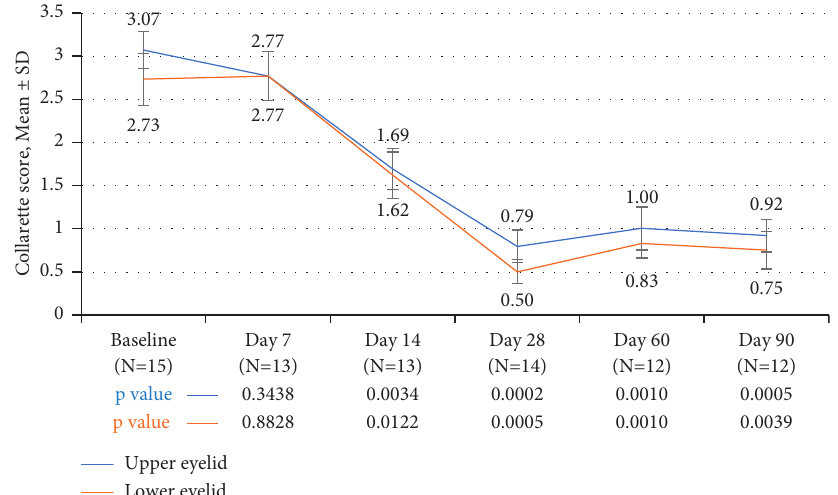
Figure 1: The difference in collarette grade from baseline was statistically significant for both upper and lower lids of analysis eyes on day 14 and every visit thereafter.